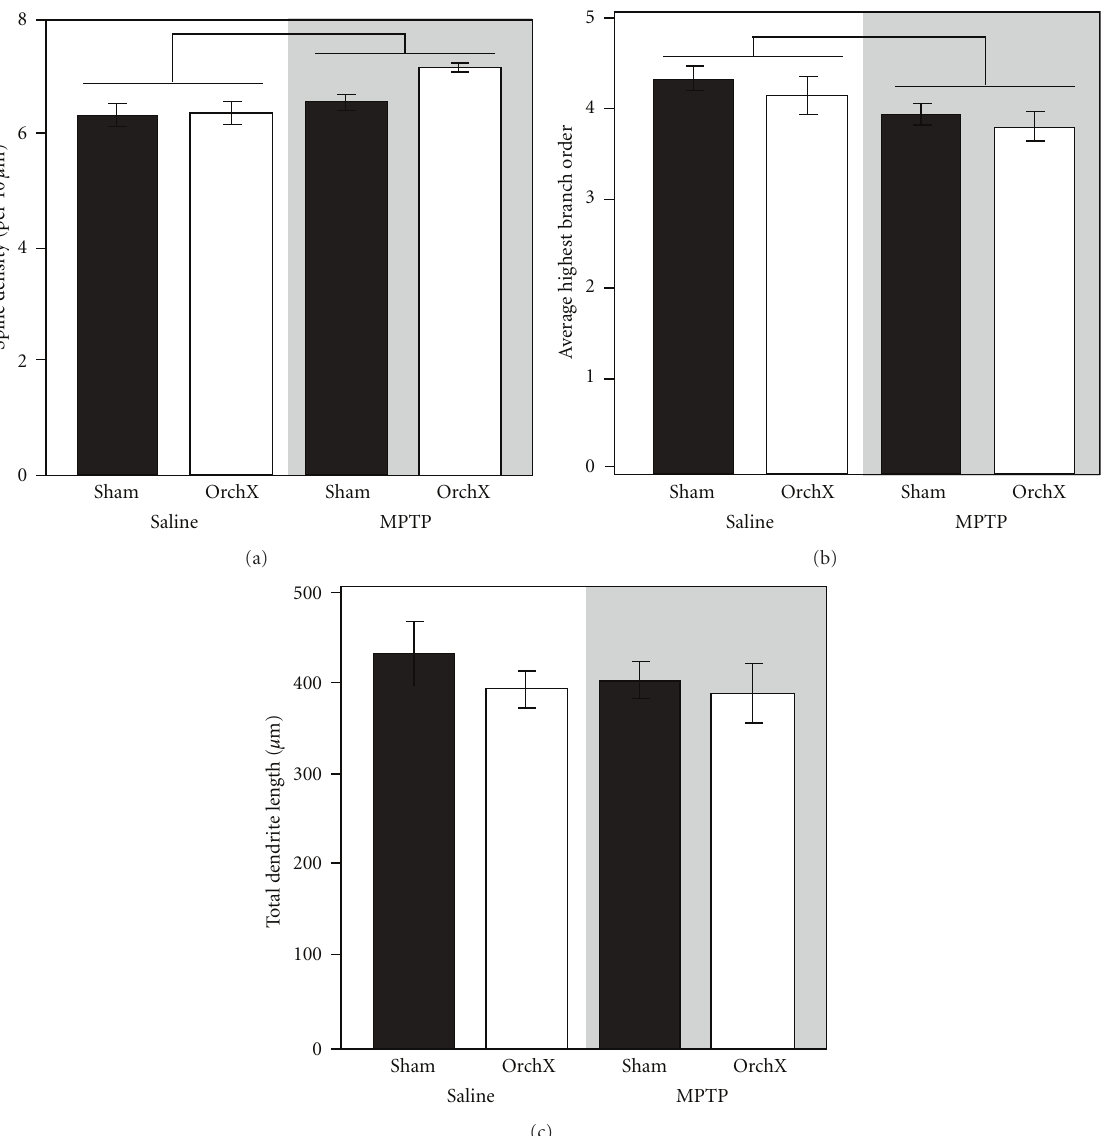
Figure 3: Neuronal morphology totals. Total spine density (a), average highest branch order (b), and total dendrite length (c) in saline- injected (unshaded panel) and MPTP-treated (shaded panel) gonad-intact (black bars) and orchidectomized (white bars) male mice ( n = 5mice/group). Bars represent an e ff ect of MPTP ( P < . 05). OrchX: orchidectomized; Sham: